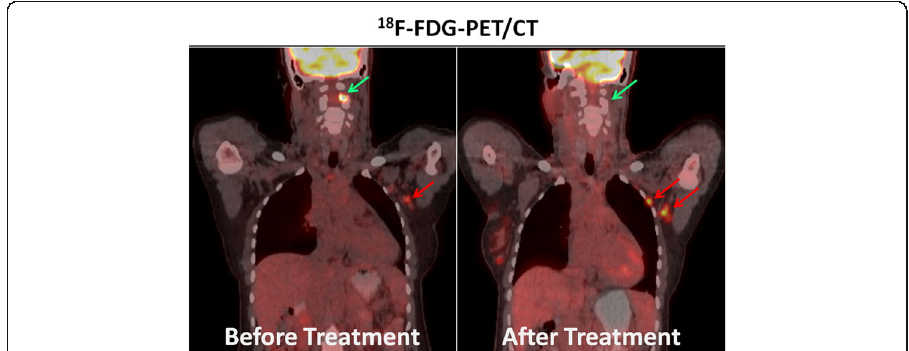
Fig. 2 18 F – FDG-PET/CTs in a patient with metastatic breast cancer before and after systemic therapy illustrating mixed treatment response. While an osseous cervical spine metastasis (green arrows) responded to treatment, several axillary lymph node metastases (red arrows) showed growth and increased FDG uptake. Mixed response to treatment is more commonly encountered in advanced, previously treated malignancies and hybrid imaging may help to prospectively identify patients in need for alternative treatment regimens